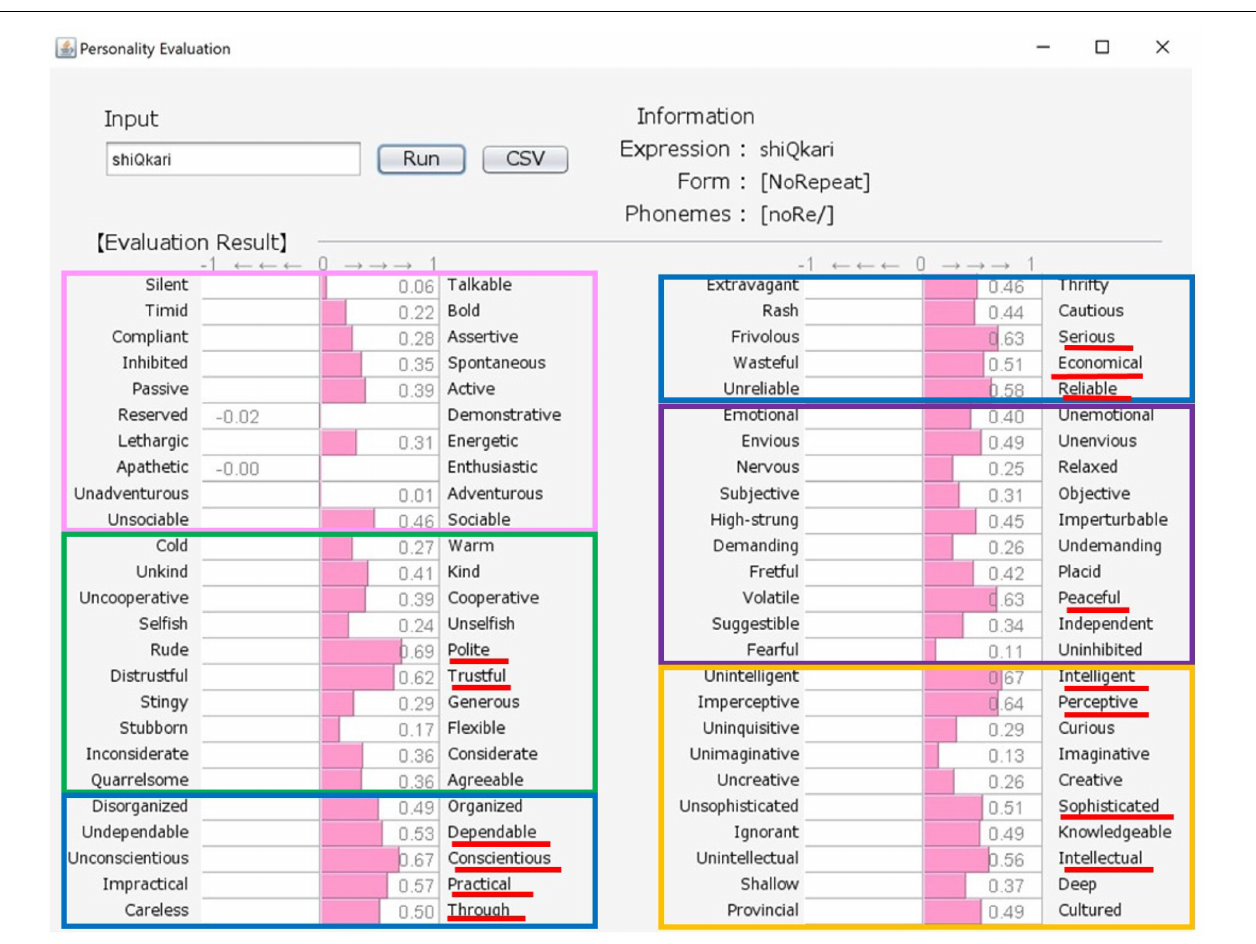
Frontiers in Psychology |